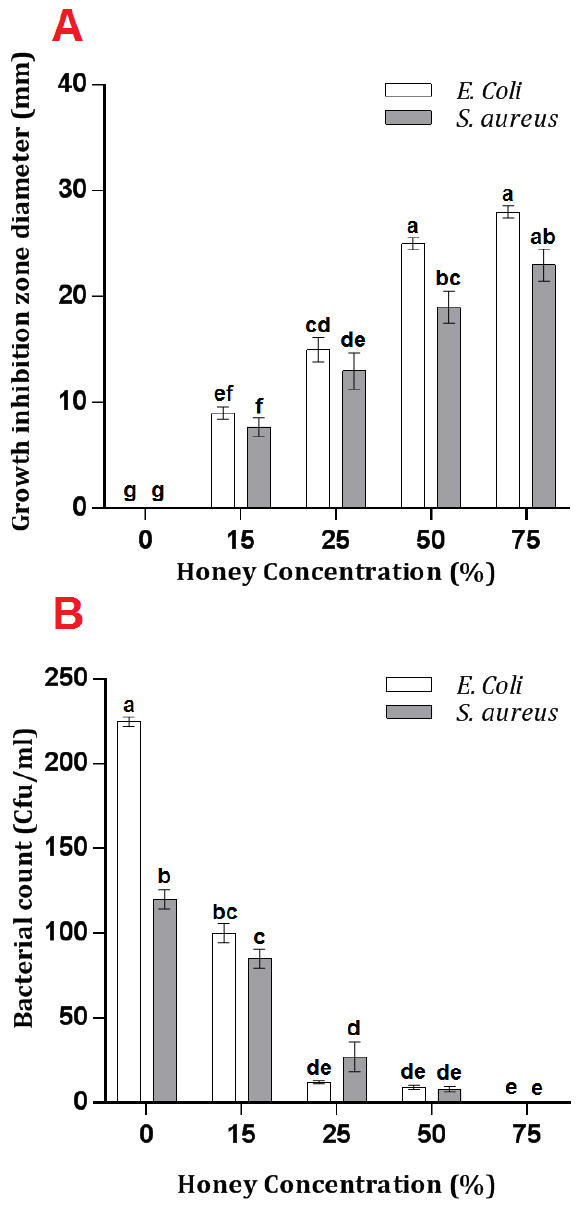
Figure 1. The effect of Capparis spinosa honey on E. coli and S. aureus using disk diffusion (A) and bacterial count (B)